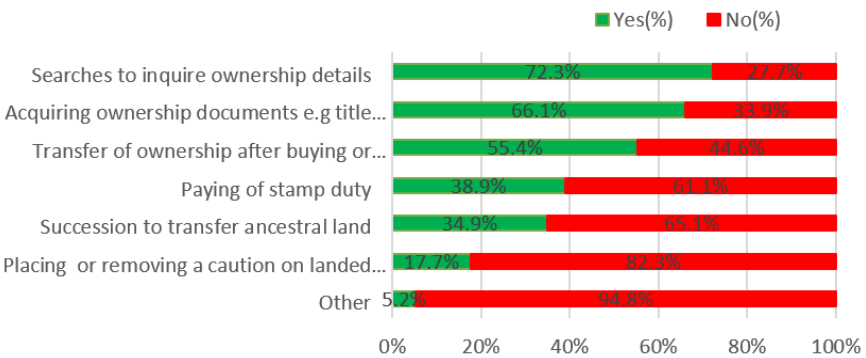
Figure 2. Kinds of inquiries at the land’s offices ( n = 401).